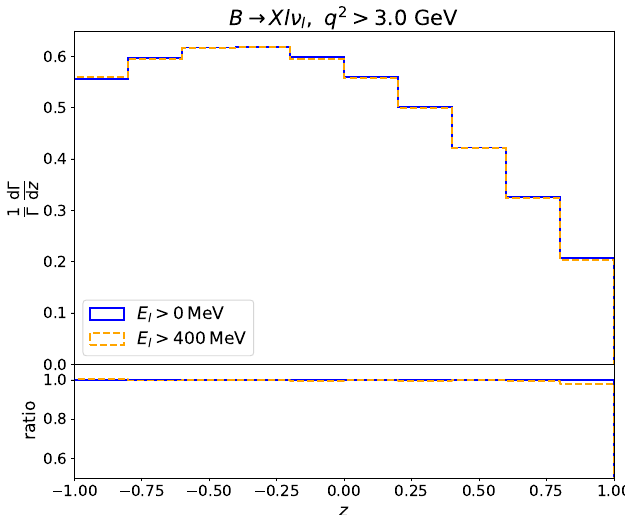
Figure 9: The angular spectrum in B → X l ν requirement on the lepton energy in the laboratory